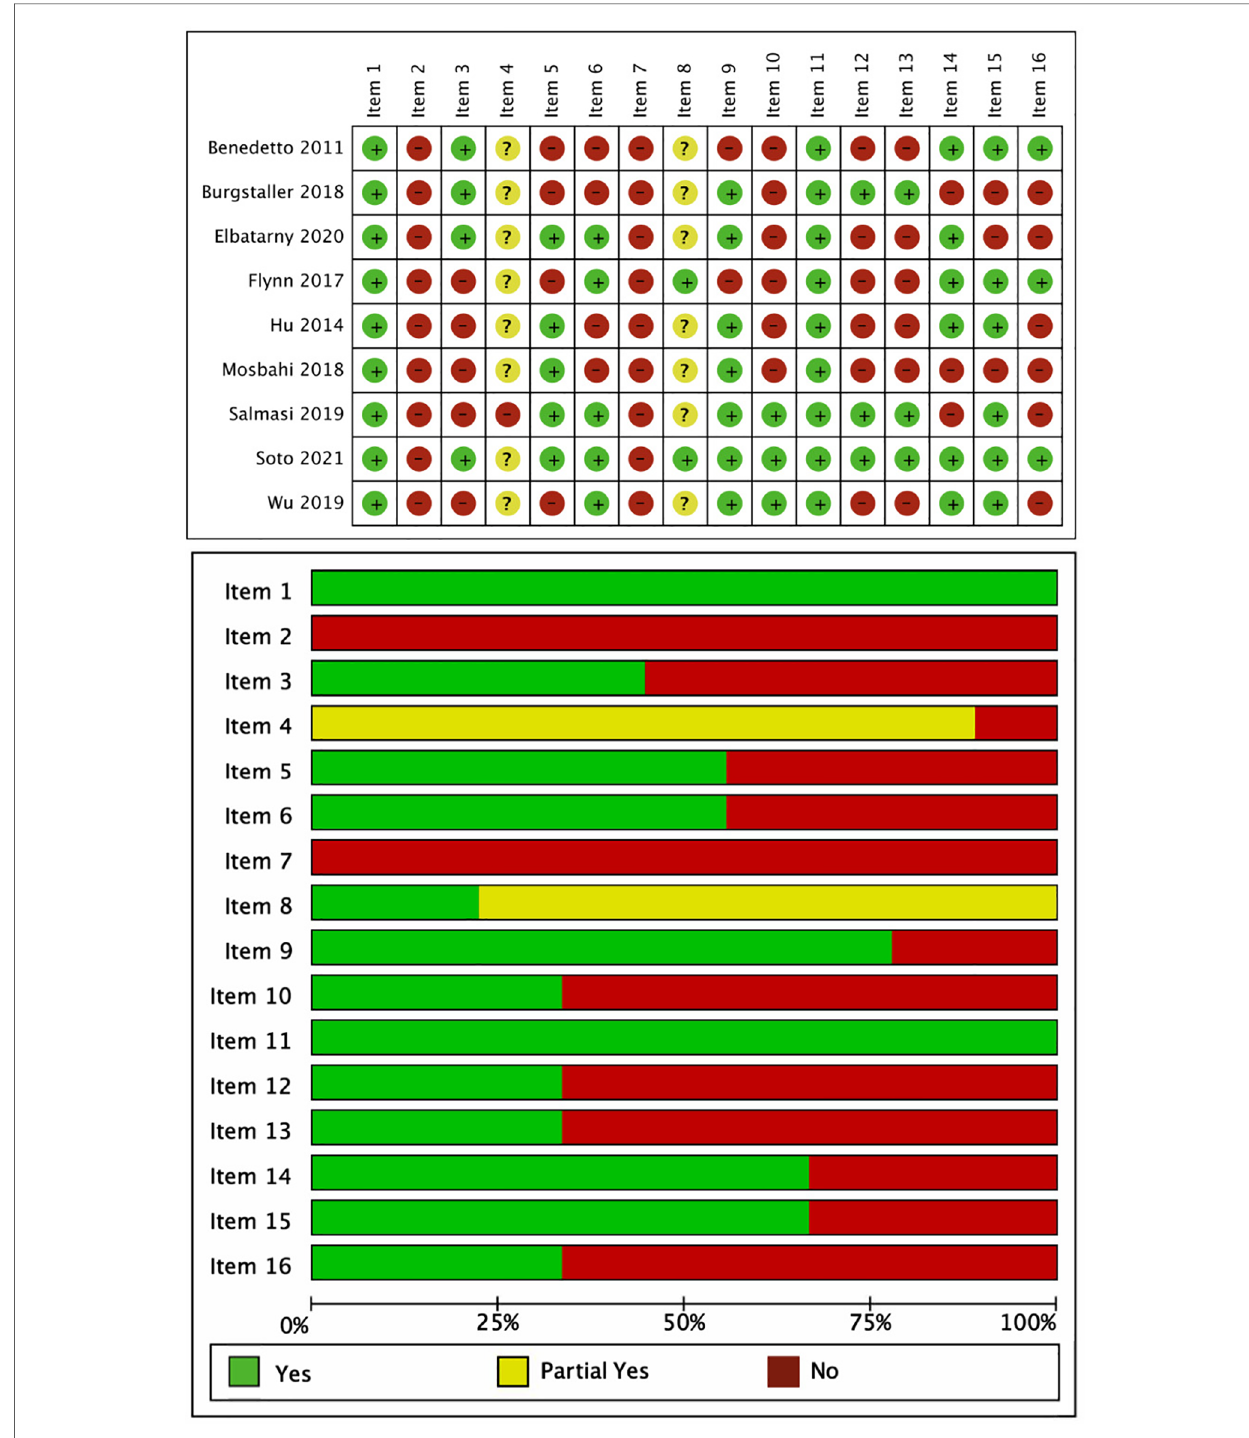
FIGURE 2 Results of the visualization quality evaluation of A Measurement Tool to Assess Systematic Reviews